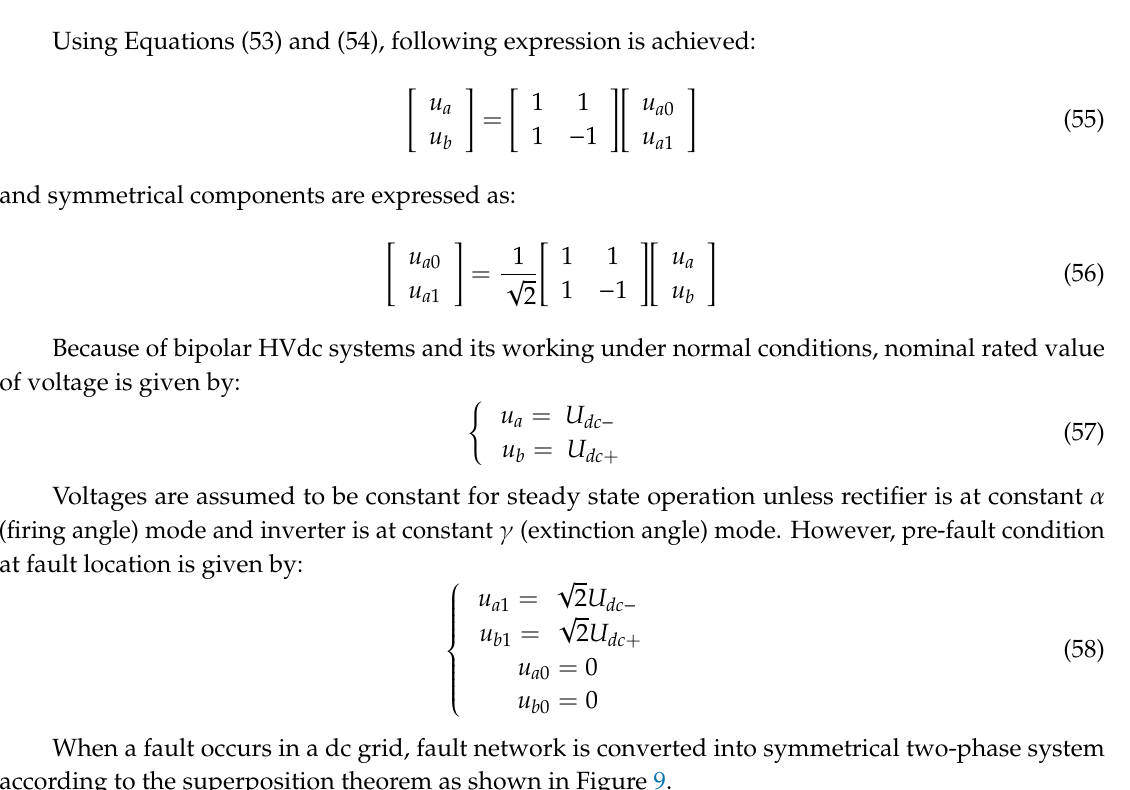
Figure 10. Bipolar voltage source converter (VSC) high-voltage direct current (HVdc) station with specified voltage and current.